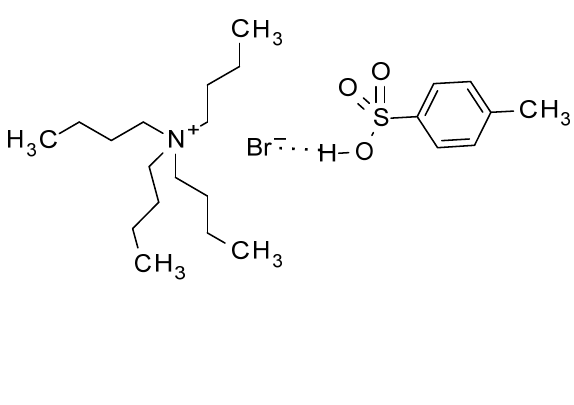
Figure 2. TBAB ion pair with the associated acid